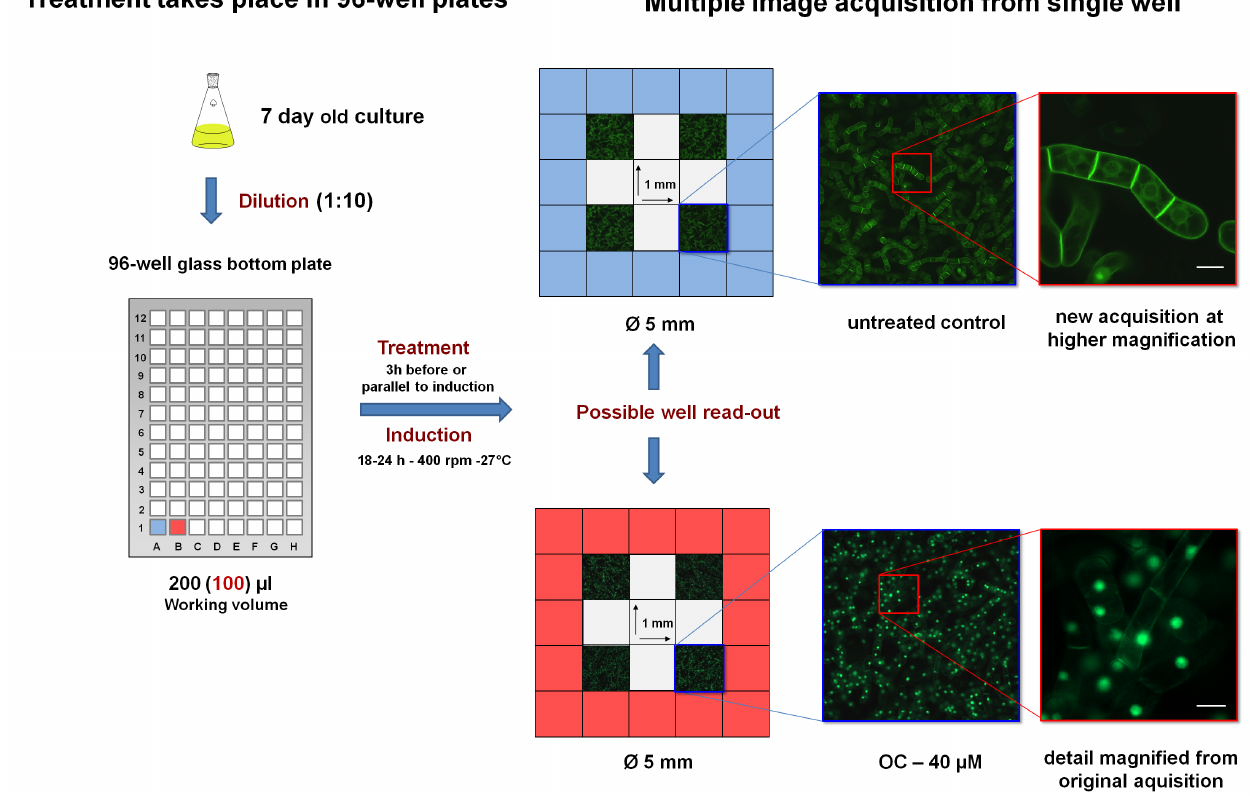
Figure 14. Image acquisition takes place in 96-well glass bottom plates. The scheme explains the steps of how the LSM microscope can scan wells. Images can be taken at low resolution to indicate the behavior of many cells for statistical evaluation. But at the same time high resolution is achieved by zooming into the image for detailed analysis of fluorescent protein localization, either to the PM (control) or to nuclei (after addition of an appropriate inhibitor like oxoclomazone (OC) at 40